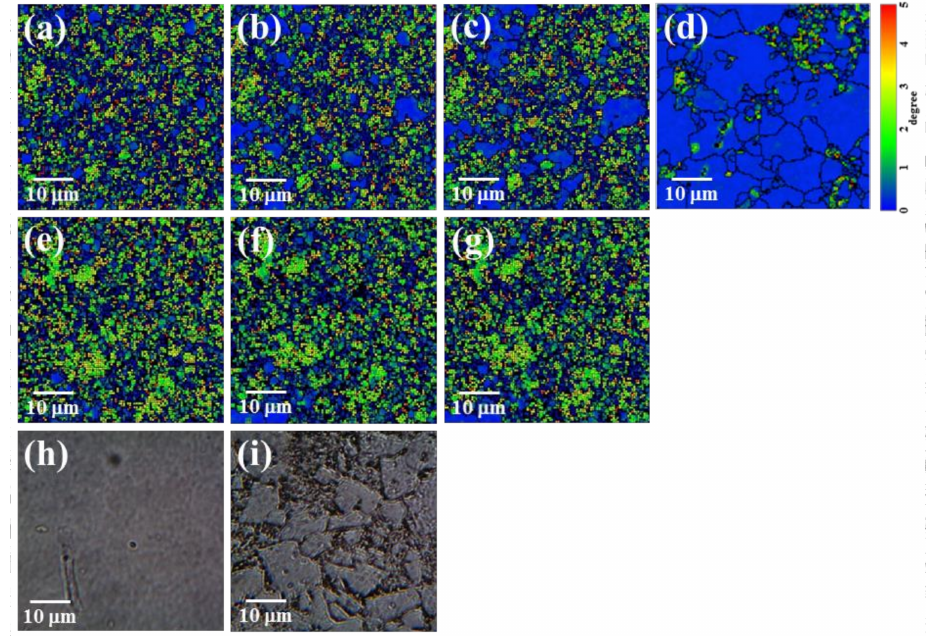
Figure 3. Time-course local misorientation of crystalline KBr in disk measured by electron backscattering diffraction (EBSD) for open-air storage: ( a ) 20 min; ( b ) 50 min; ( c ) 120 min; ( d ) 13 h; and for vacuum storage: ( e ) 30 min; ( f ) 80 min; ( g ) 180 min. Optical microscope images of a KBr disk for the open-air storage case: ( h ) 0 min; ( i ) 180 min. The EBSD measurements were conducted in a high-vacuum SEM